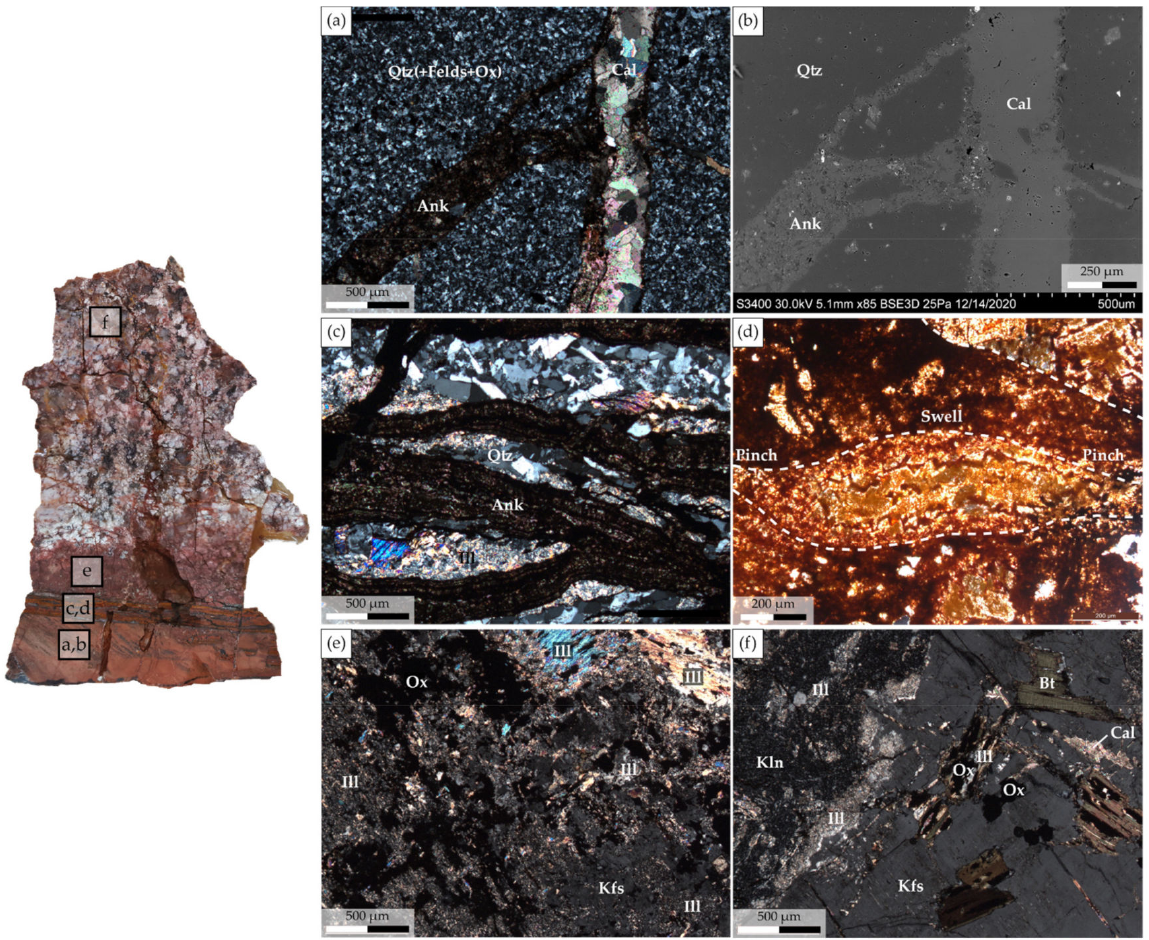
Figure 14. Photomicrographs of the different compartments of the sample and their location in the sample. ( a ) Veins of ankerite and calcite crosscutting the major quartzitic/feldspathic vein of the sample under optical microscope in polarized–analyzed light. ( b ) Back-scattered electron image of the photomicrograph ( a ). ( c ) Photomicrograph of the ankerite–granite interlayering zone under optical microscope in polarized–analyzed light. ( d ) A zoom image of the ankerite vein, under optical microscope in polarized–analyzed light, presented in ( c ) and showing a sigmoid of ankerite with a swell of automorphic crystals crushed and stretched in the pinches. ( e ) The altered granite close to the vein showing a completely altered plagioclase and biotite both replaced by illite and oxides and partially altered K-feldspar under optical microscope in polarized–analyzed light. ( f ) The altered granite away from the vein showing a completely altered plagioclase replaced by illite and kaolinite, biotite partially replaced by illite and oxides, an unaltered K-feldspar, and calcite veinlets under optical microscope in polarized–analyzed